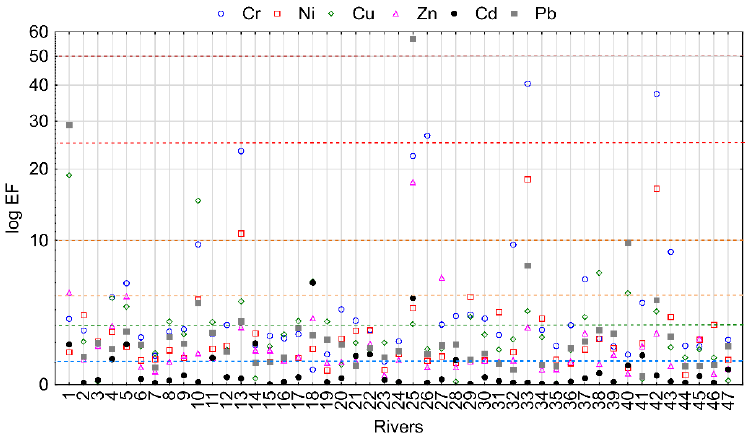
Figure 4. EF value for analyzed HMs. The numbers of sampling points are listed in the Appendix A.